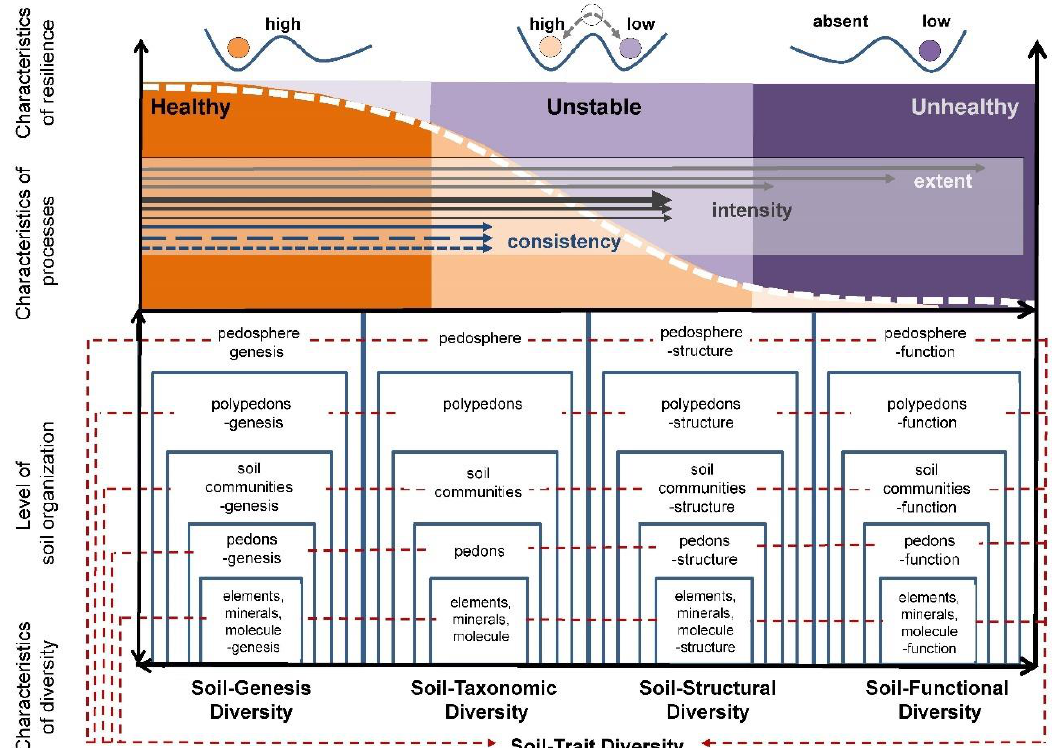
Figure 1. Five characteristics of soil diversity: Soil diversity as part of geodiversity can be described under five characteristics: Soil-genesis diversity, soil-taxonomic diversity, soil-structural diversity, soil-functional diversity, and soil-trait diversity. All of the characteristics involve different levels of soil organization from elements, minerals, molecules, pedons, soil communities, polypedons, up to pedoshere. Different characteristics of the processes (the extent, process intensity, process consistency, resilience, and their characteristics) influence the resilience of soil and ecosystem health (modified after Lausch et al. [57]).